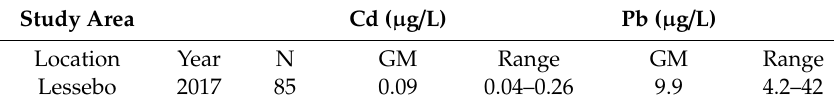
Table 2. Levels of cadmium (Cd) and lead (Pb) in blood in the study population.